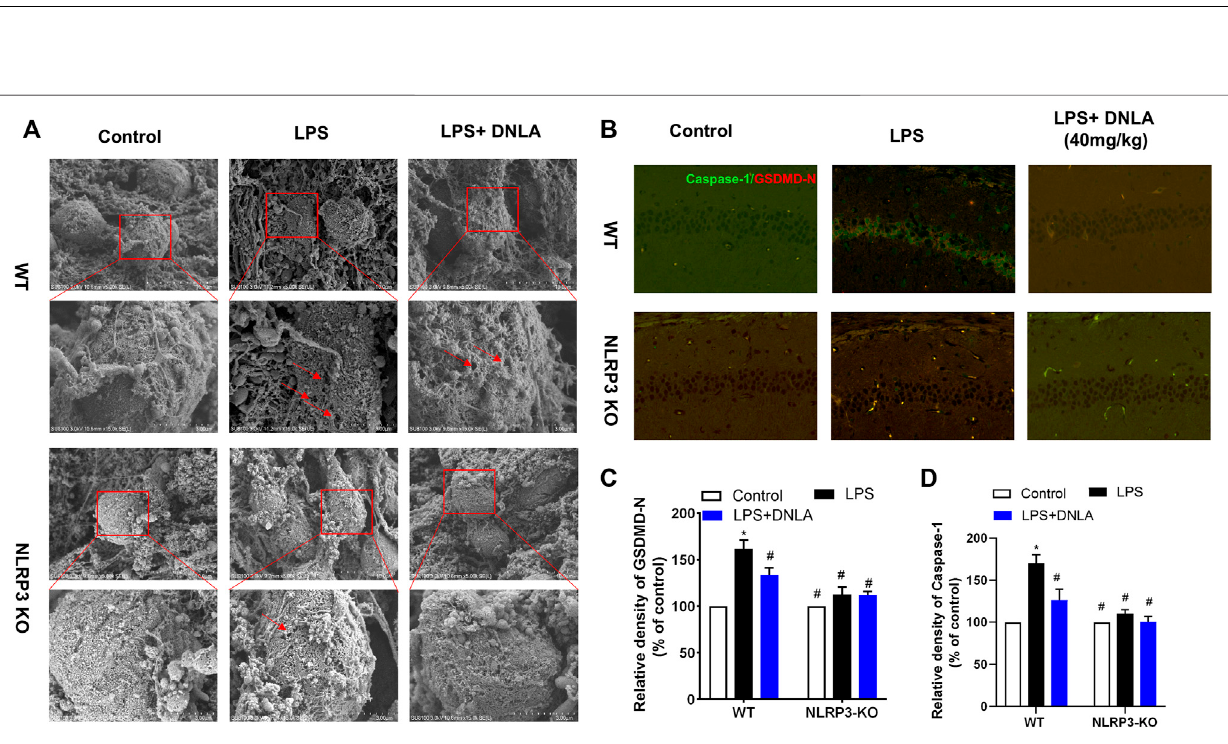
FIGURE 7 | DNLA suppressed pyroptosis through inhibition of NLRP3 signaling. After DNLA treatment for 14 days, the cell membrane structure of the hippocampal neurons was discerned using the scanning electron microscope (A) . Protein expressions of caspase-1 and NLRP3 in hippocampus CA1 were measured by immuno fl uorescence staining. The green color indicates caspase-1-positive cells, and red color indicated GSDMD-N-positive cells. Scale bar = 50 μ m (B) . QuantitativeanalysisofproteindensityofGSDMD-N (C) andcaspase-1 (D) .* p < 0.05compared withtheWTcontrolgroup; # p < 0.05comparedwiththeWTLPS- treated group. Data were expressed as mean ± SEM ( n =